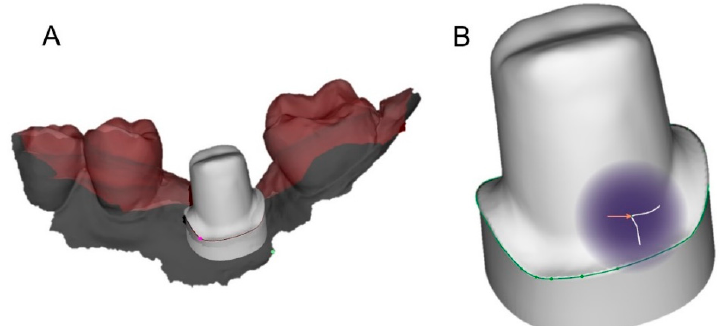
Figure 10. Second CAD scene (PLAN2) with the design of the final restoration. ( A ) the margine line of the individual hybrid abutment is clearly visible, even if subgingival, and therefore automatically detected by the software; ( B ) the dental technician can always control the margin line and modify it.